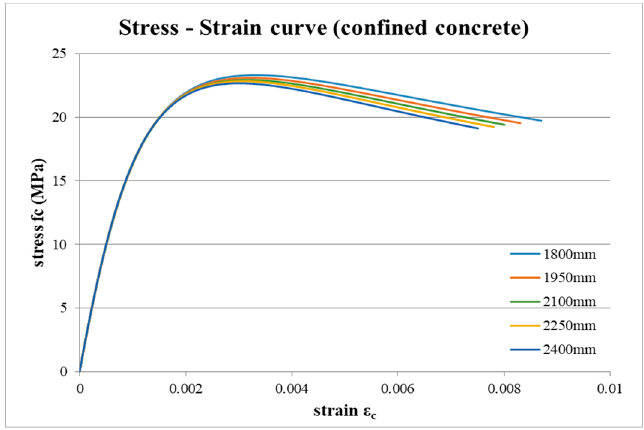
Figure 5. Stress–strain curve for confined concrete.